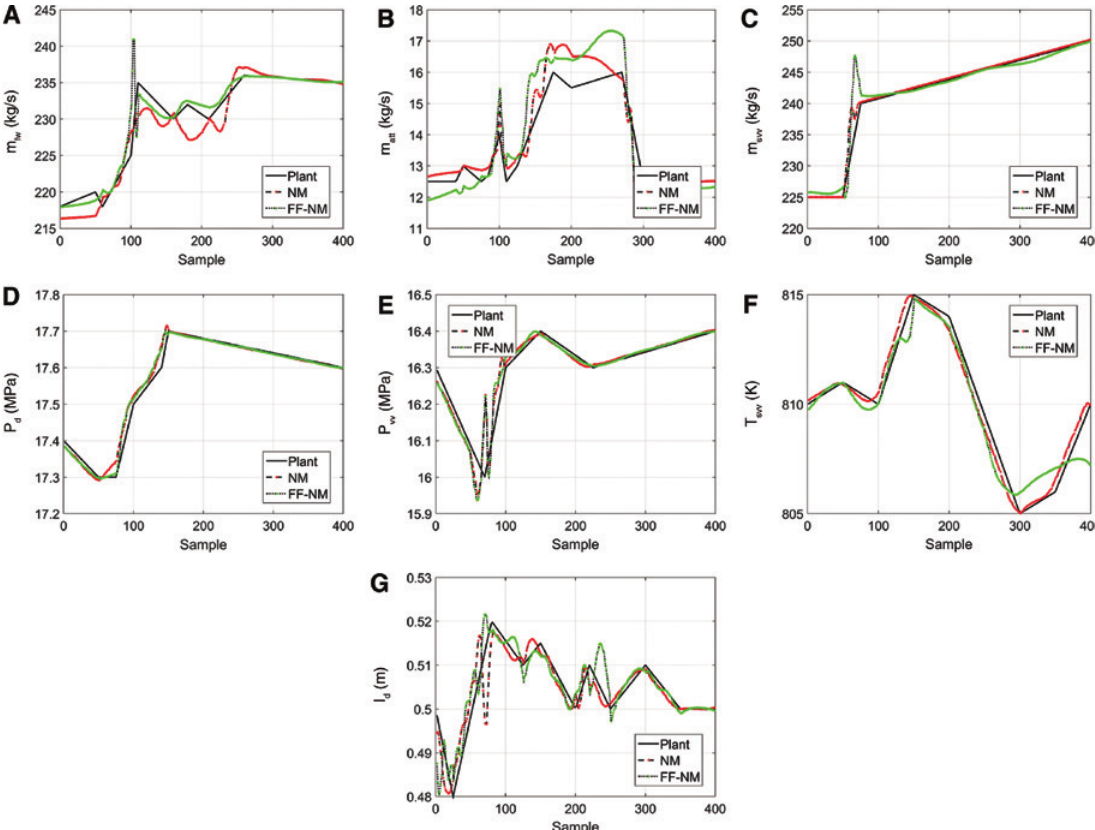
Figure 7: Correlation between the Output of Different Models from Test Case